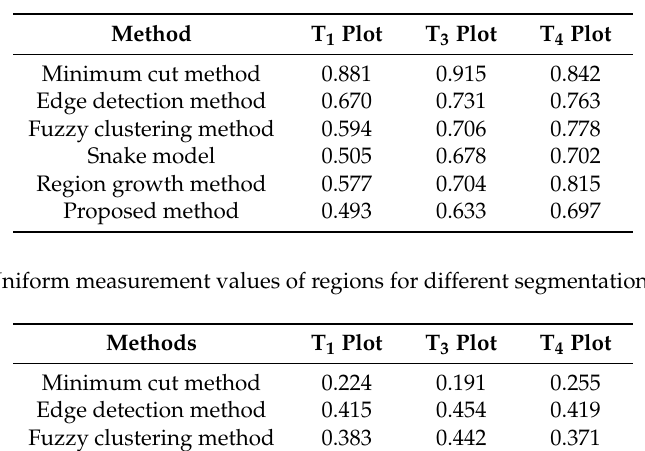
Table 5. Inter-region contrast values for different segmentation methods.